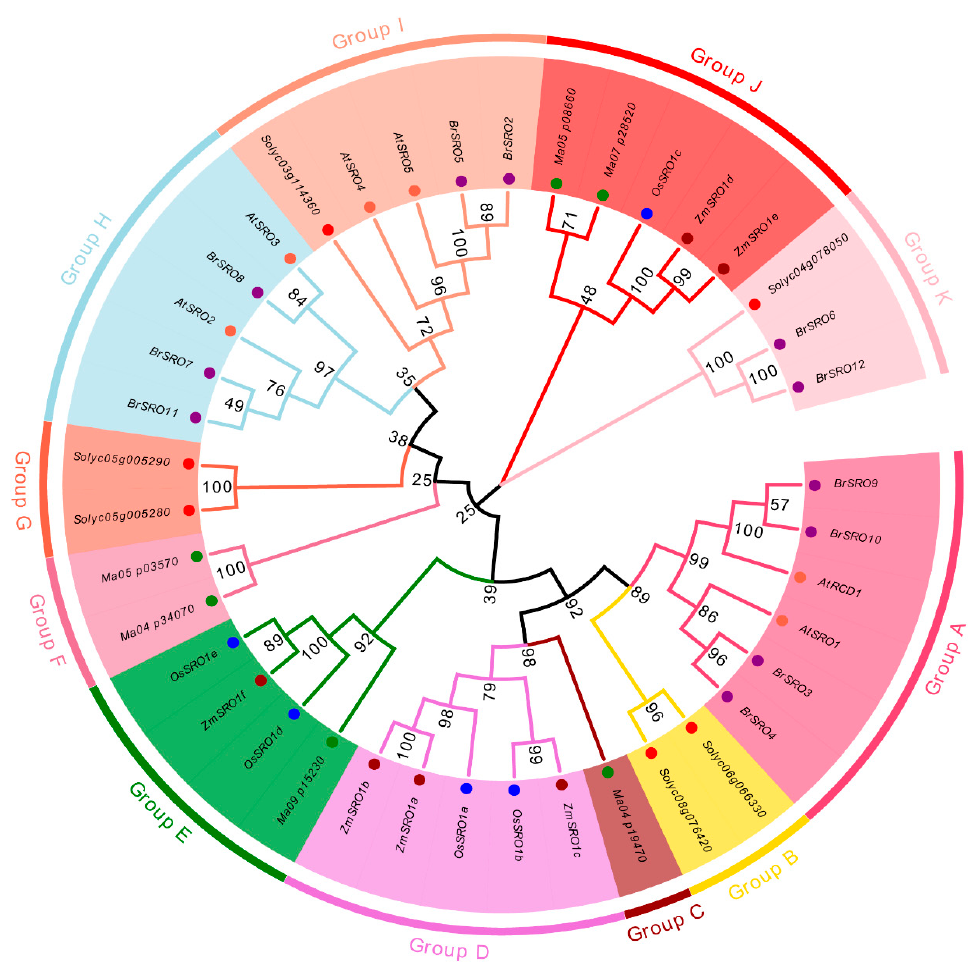
Figure 2. Phylogenetic tree of the similar to radical-induced cell death 1 ( SRO ) genes from Arabidopsis thaliana (At), Solanum Lycopersicum (Sl), Brassica rapa (Br), O. sativa (Os), Zea mays (Zm), Musa acuminate (Ma). In total, 6 AtSROs, 6 SlSROs, 11 BrSROs, 5 OsSROs, 6 ZmSROs, and 5 MaSROs were included. The phylogenetic tree was constructed for the SRO protein sequences in Arabidopsis thaliana (tomato), Solanum Lycopersicum (red), Brassica rapa (purple), Oryza sativa (blue), Zea mays (darkred) and Musa acuminate (green) using the Maximum-Likelihood method in MEGA 7.0. Bootstrap values from 1000 replicates are displayed at each node. The proteins on the tree can be divided into 11 groups from Group A to Group K, and the different groups are indicated by different colors.